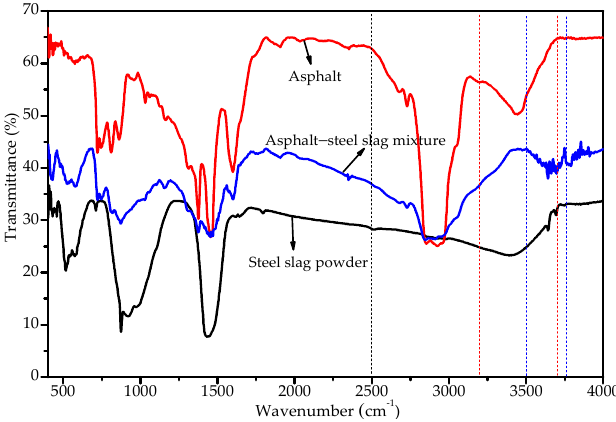
Figure 12. FT–IR spectra of the asphalt–steel slag mixture.